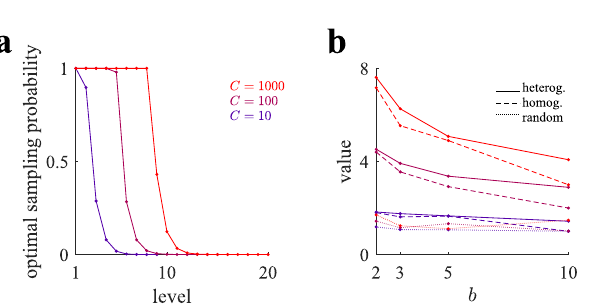
Figure 7. Optimal heterogeneous policies spread samples into the future more deeply than homogeneous policies. ( a ) Optimal sampling probabilities q per level for three capacities and for b = 2 . While for optimal homogeneous policies sampling probabilities equal one except, possibly, for the last level, optimal heterogeneous policies assign non-zero sampling probabilities to deeper levels. ( b ) Value of playing the tree with heterogeneous (full lines), homogeneous (dashed) and random (dotted) policies as a function of the number of considered branches b for three capacities (color code as in previous panel). The optimal value is attained when b = 2 for all cases. Note that optimal values for homogeneous policies are below but very close to the optimal values of heterogeneous policies. For heterogeneous and random policies, we limit the number of considered levels somehow arbitrarily to d = 2 ⌊ ln ( C )/ ln ( b ) ⌋ + 3 , where ⌊ x ⌋ is the floor function, which allows in a simple way agents to spread samples, if optimal, well beyond the sampled levels by homogeneous policies. Random policies allocate samples with the same probability to every node of the tree of depth d and also satisfy the finite capacity constraint, Eq. (6). Optimal policies and values for heterogeneous and for homogeneous selective allocations are computed using Eqs. (4,5,7) and Eqs. (4,5,8) for p = 1 2 , respectively, inside a gradient ascent (see Sect. “Gradient ascent” of the Methods). For different p results are